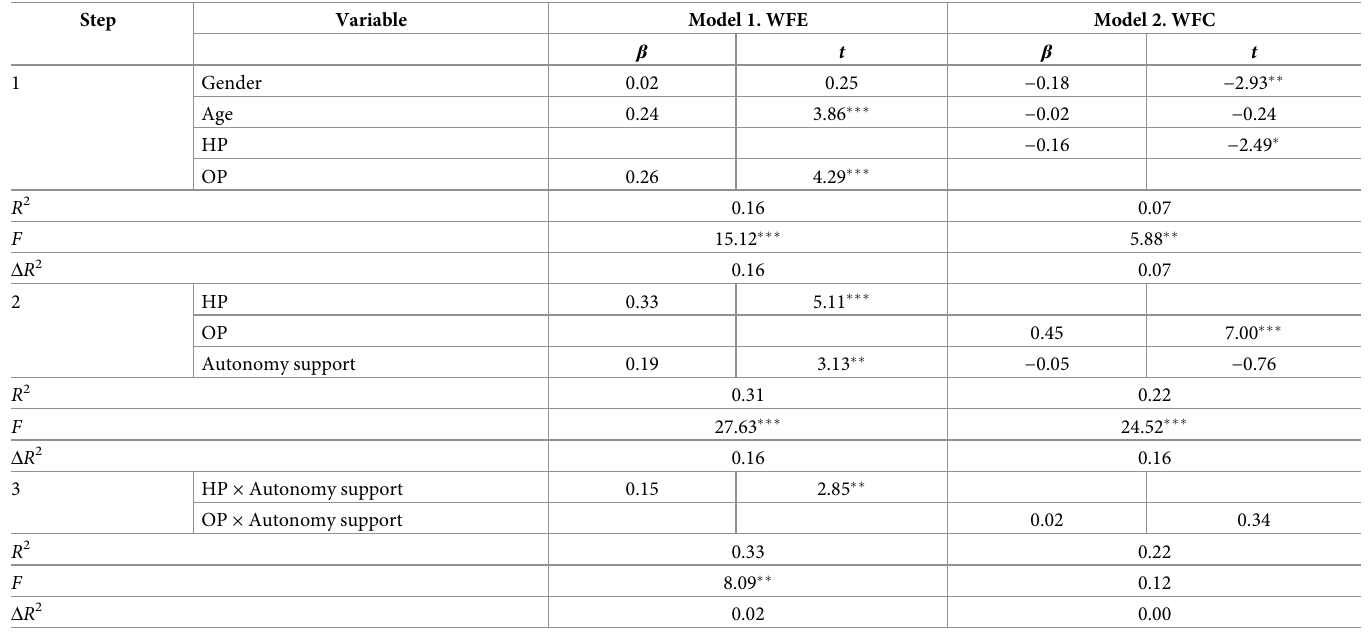
Table 2. Moderating effects of autonomy support of the relationships between harmonious and obsessive work passion on work–family enrichment and work–fam- ily conflict.